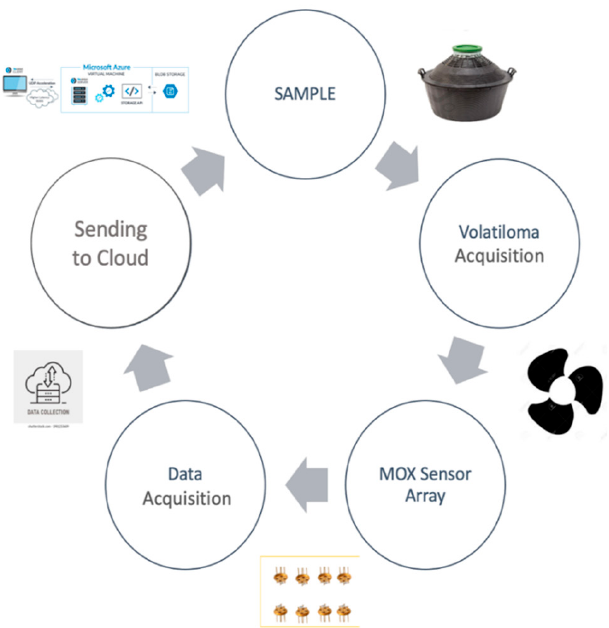
Figure 3. Flow Sheet Sensor Analysis.